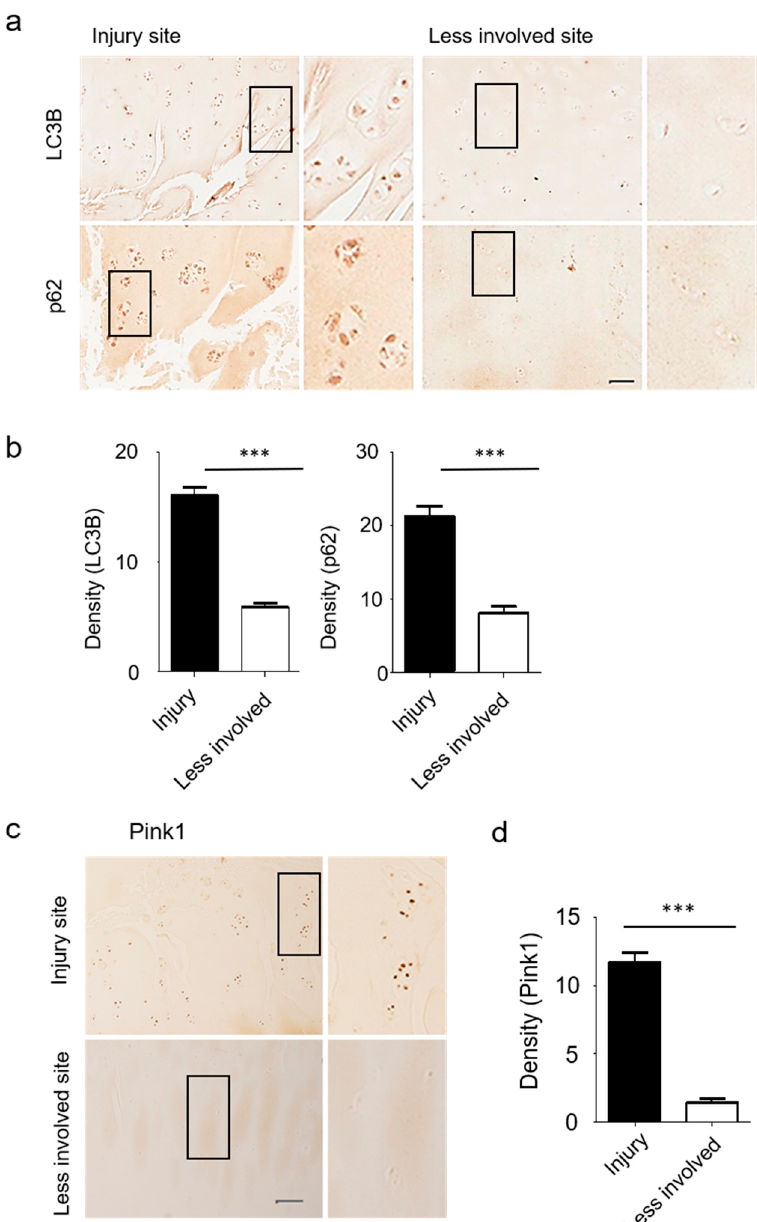
Figure 5. Cartilage from human OA patients revealed increased autophagy and mitophagy-related gene expression levels. ( a , b ) Expression of LC3B and p62 were prominent at the site of cartilage injury in OA patients. ( c ) Expression of Pink1 protein in human OA knee cartilage was measured by immunohistochemistry. ( d ) The density of Pink1 in injured and less involved site was quantified with Image J. Scale bar = 50 µm.